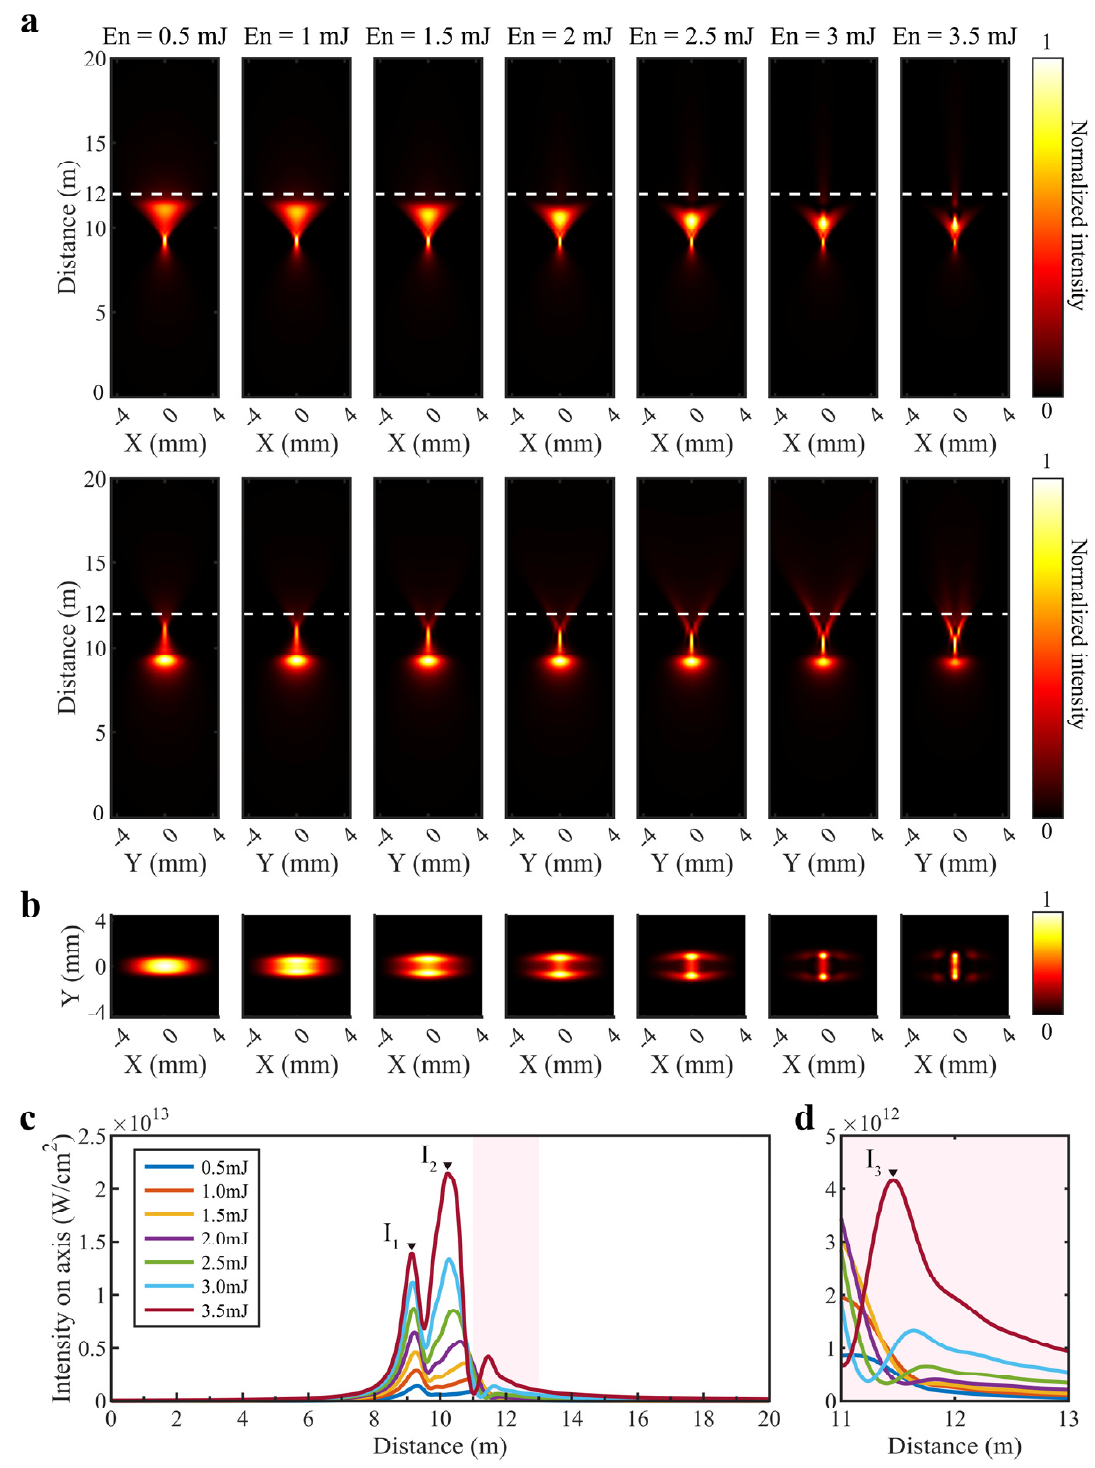
Figure 2. Numerical simulation results of the astigmatic Gaussian beam focused at 10 m under nonlinear conditions: ( a ) Intensity profiles in the x-z and y-z plane as a function of propagation distance at different single pulse energies; ( b ) Intensity distributions in the x-y plane at z = 12 m (the white dashed lines in ( a ); ( c ) On-axis intensity extracted from ( a ); ( d ) The enlarged part of the pink area in c is shown in ( d ).